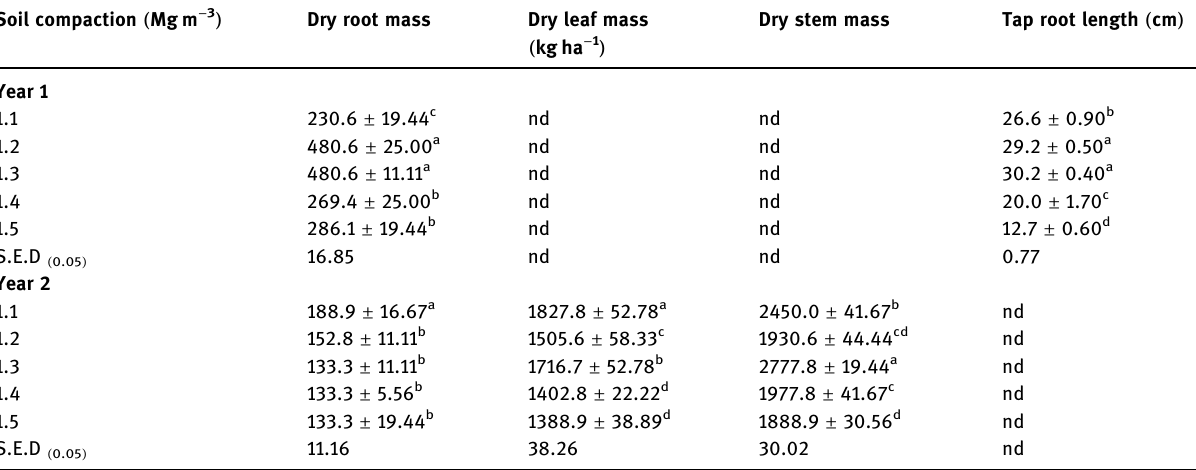
Table 4: E ff ect of soil compaction on dry mass of groundnut growth parameters Soil compaction ( Mg m − 3